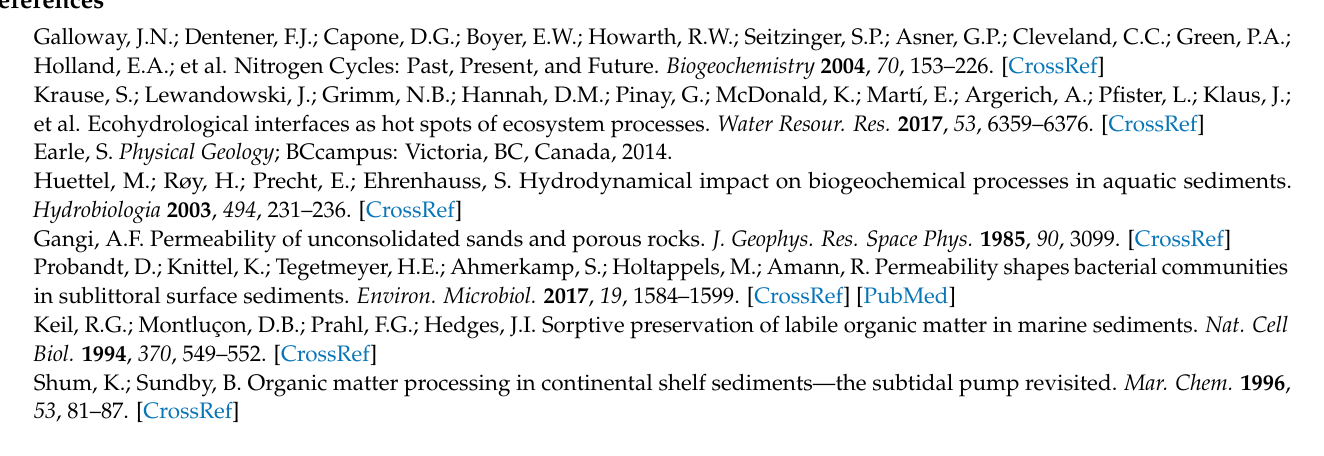
Table S2: Hydrodynamics and water physico-chemistry in the Qi River and the three inoculated reaches; Figure S1: The amplification and dissociation curves of the qPCR; Figure S2: Correlations between water chemistry and sediment chemical characteristics; Figure S3: Correlation matrix of sediment physical and chemical characteristics; Figure S4: The chemical parameters of the sandy sed- iment with different reaches, particle median sizes, and heterogeneities; Figure S5: Three denitrifier community compositions (at the family level) within 24 different